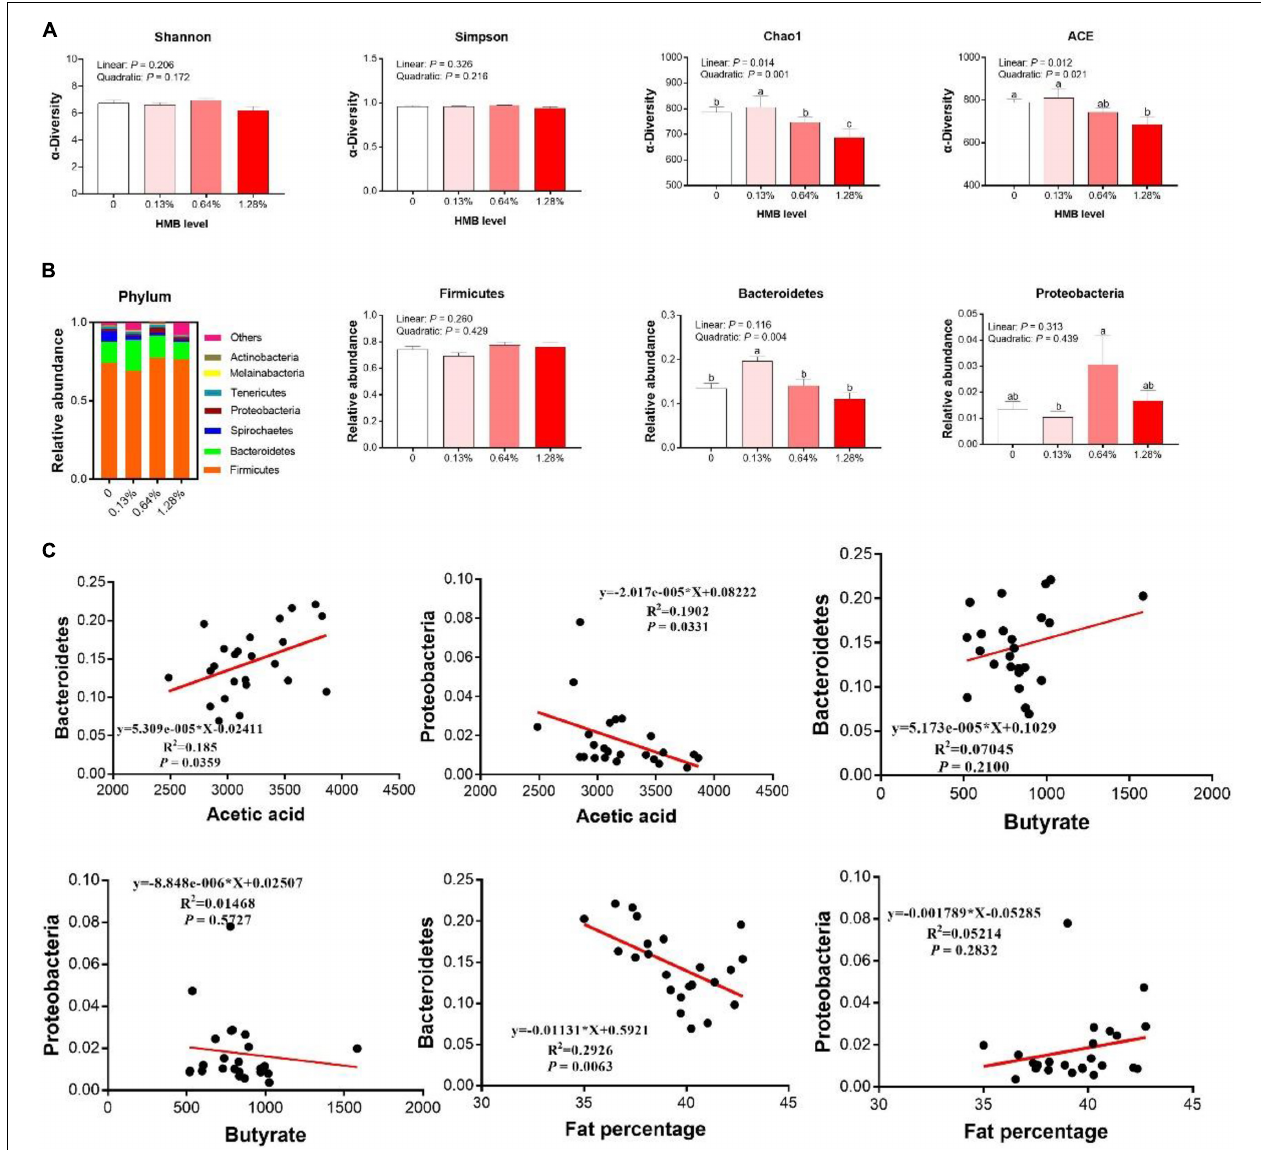
FIGURE 5 | Dietary HMB supplementation improved gut microbiota in Bama Xiang mini-pigs. The α -diversity analysis (A) , microbiota composition at the phylum level (B) , the correlation analyses between the relative abundance of Bacteroidetes / Proteobacteria and acetic acid/butyrate, the correlation analyses between the relative abundance of Bacteroidetes / Proteobacteria and fat percentage (C) . Data are presented as mean ± SEM ( n = 8). a , b , c Values with different letters are significantly different among dietary HMB treatments ( P <